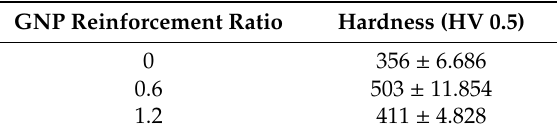
Table 4. Hardness of the fabricated